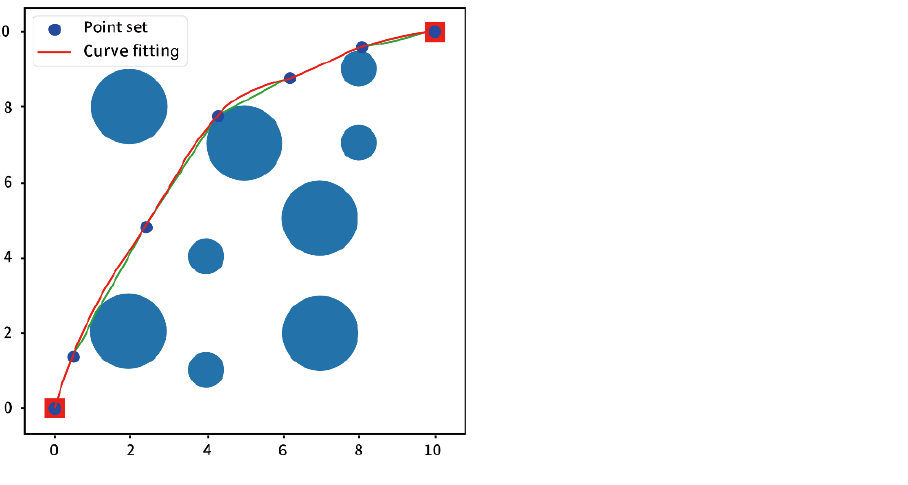
Figure 5. Trajectory with spline through n points. Comparison of generated paths before and after path smoothing.